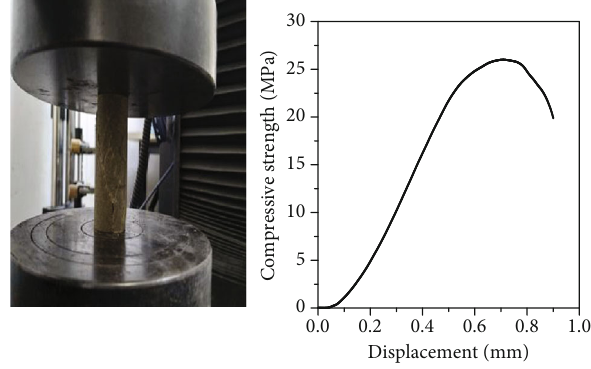
Figure 1: Sandstone stress-strain